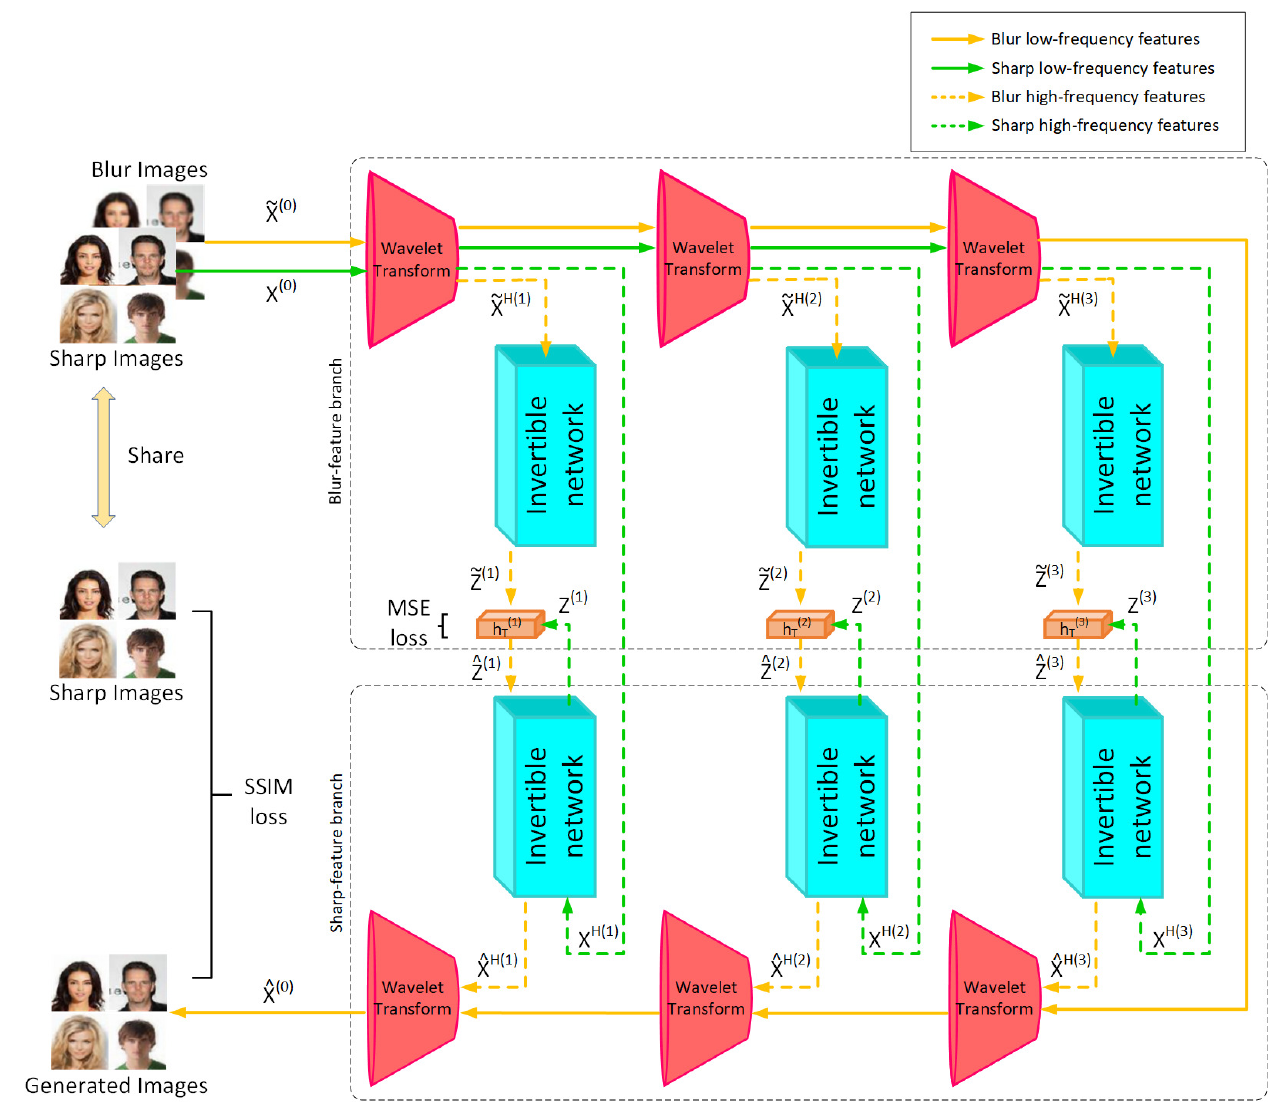
Figure 1. The proposed network architecture for image deblurring. The solid line indicates the low-frequency features and the dashed line indicates the high-frequency features. First, the blur- sharp pairs are decomposed by wavelet transform to obtain the corresponding high-frequency features and low-frequency features, then the latter continues to be decomposed downward, and the former is mapped to latent variables by the invertible networks and the hierarchical optimization loss is calculated in this space. Finally, the sharp-feature branch is further optimized by using the similarity